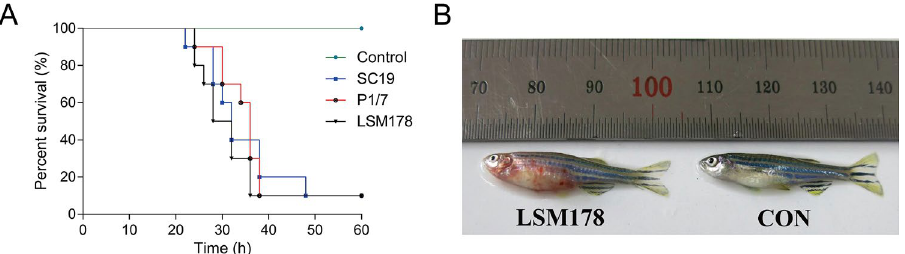
Figure 1. Evaluation of the virulence of the LSM178 in zebrafish. ( A ) Survival rate of zebrafish infected with LSM178, SC19 and P1/7. ( B ) Images of zebrafish infected with LSM178. Zebrafish injected with PBS were used as the control. Each group contained 10